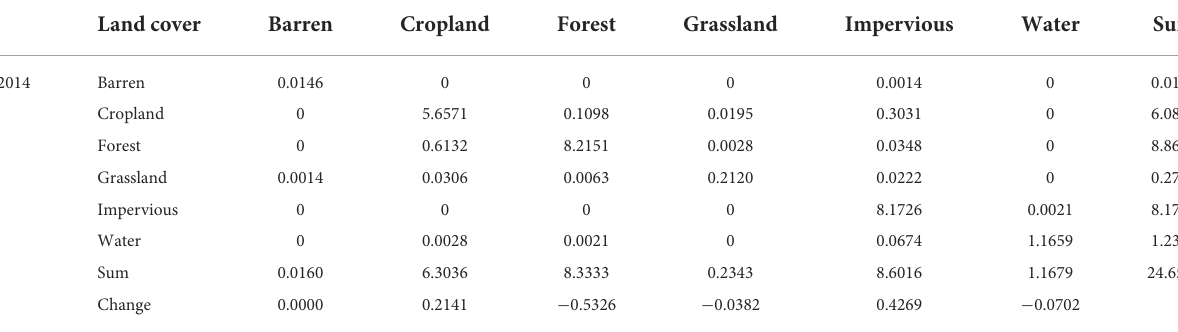
TABLE 4 Land use change from 2014–2019 (km 2 ).